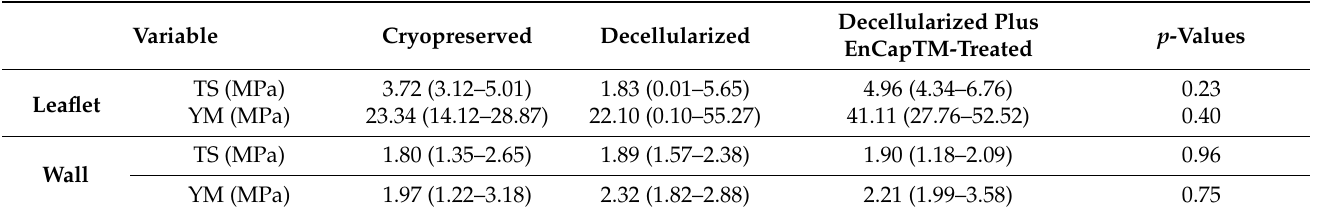
Table 1. Baseline TS and YM of cryopreserved, decellularized unfixed, and decellularized